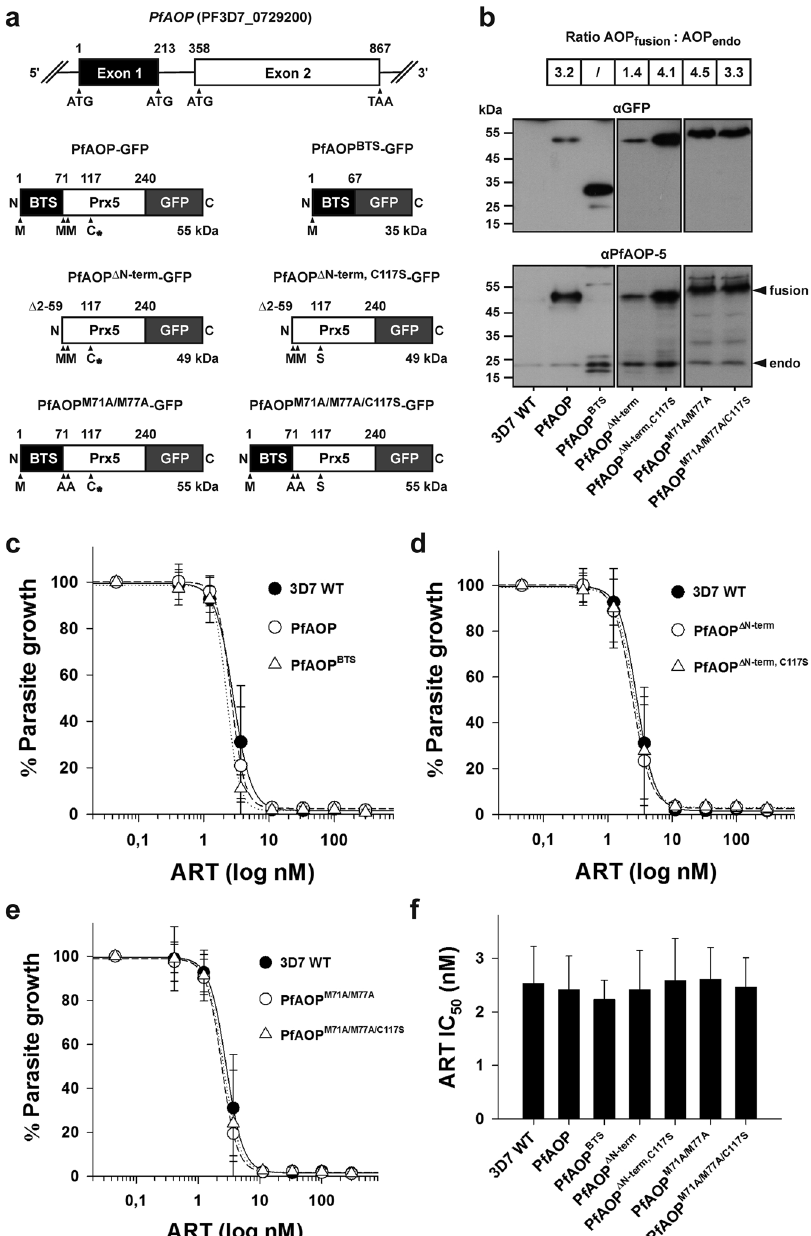
Figure 3. IC 50 values for artemisinin of parasites that overexpress PfAOP . ( a ) The modular gene architecture of PfAOP is shown on top. Exon 1 encodes the bipartite topogenic signal (BTS) and exon 2 the Prx5 domain. Constructs encoding cytosolic truncated as well as apicoplast-targeted full length GFP-fusion proteins of Pf AOP are depicted below and were overexpressed in strain 3D7 as described previously 41 . Residue Cys117 at the active site of Pf AOP was shown to be essential for the hydroperoxidase activity 45 and is labelled with an asterisk. The residue was mutated to serine in controls. ( b ) Western blot analyses confirming the overexpression of the GFP- fusion constructs listed in panel (a). Detection of GFP in the upper blot revealed no significant degradation of the fusion proteins. Hence, detection of Pf AOP at approximately 22 kDa reflects only endogenous Pf AOP (endo) whereas the upper bands in the same blot reflect the GFP-fusion constructs (fusion). Representative images were obtained by standard western blotting. The estimated ratio between both protein species is summarized on top and is based on semi-quantitative western blotting using a C-DiGit Blot Scanner in parallel experiments. ( c – e ) Artemisinin dose-response curves of strain 3D7 blood stage cultures that express the indicated GFP-fusion constructs from panel a. All data are the mean ± standard deviation of at least three independent triplicate measurements. ( f ) IC 50 values obtained from panels c-e. None of the differences between the IC 50 values was found to be significant (p > 0.05) based on statistical analyses in SigmaPlot 12.5 using the one way ANOVA